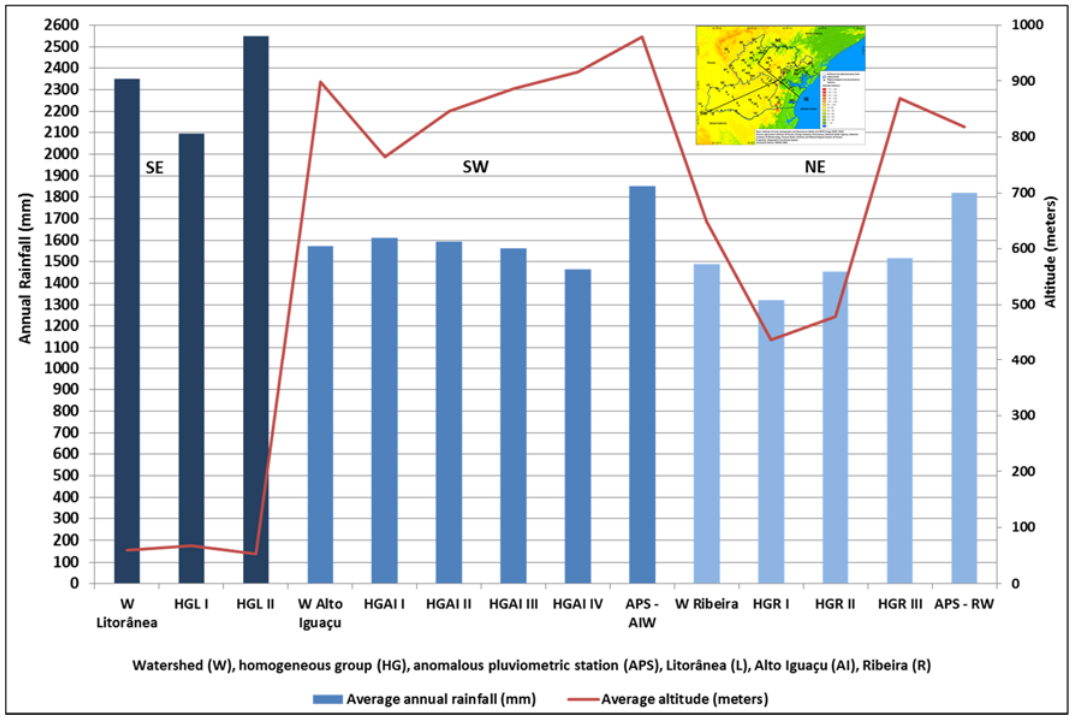
Figure 7. Average annual rainfall (mm) and average altitude (meters) for the homogeneous groups and anomalous pluviometric stations.